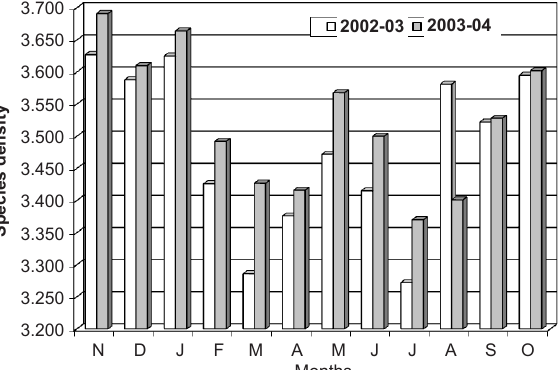
Figure 9. Monthly variations in species diversity of phytoplankton of Utra Pat Figure 10. Monthly variations in species diversity of phytoplankton of Waithou